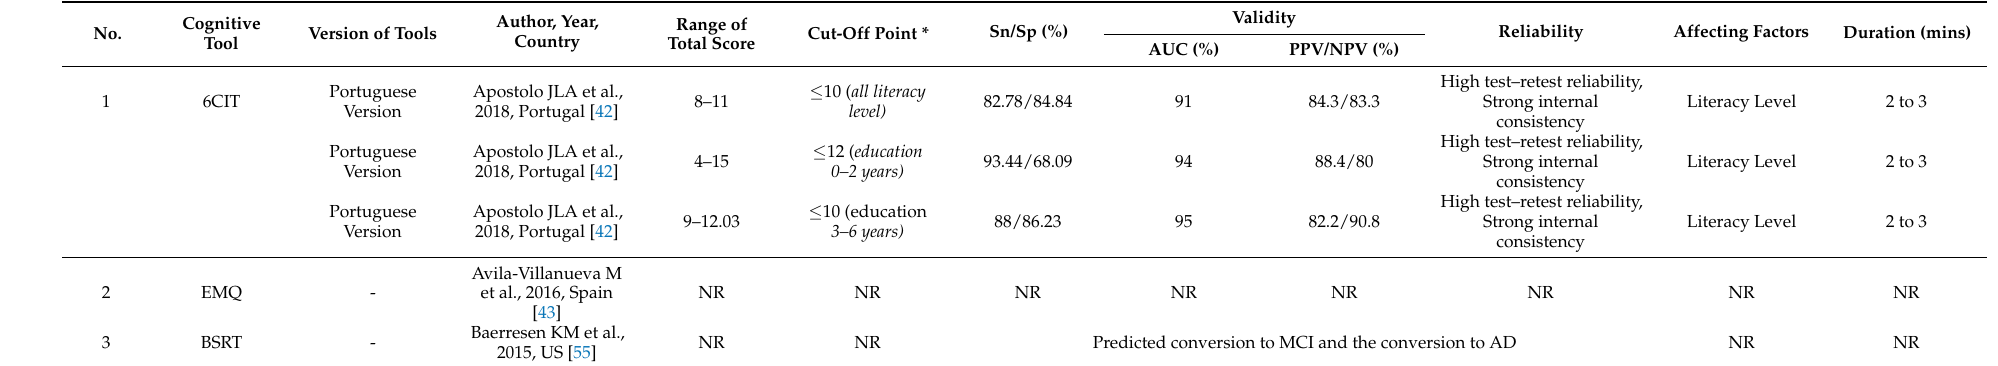
Table 4. Psychometric Properties of Cognitive Tools to Detect Mild Cognitive